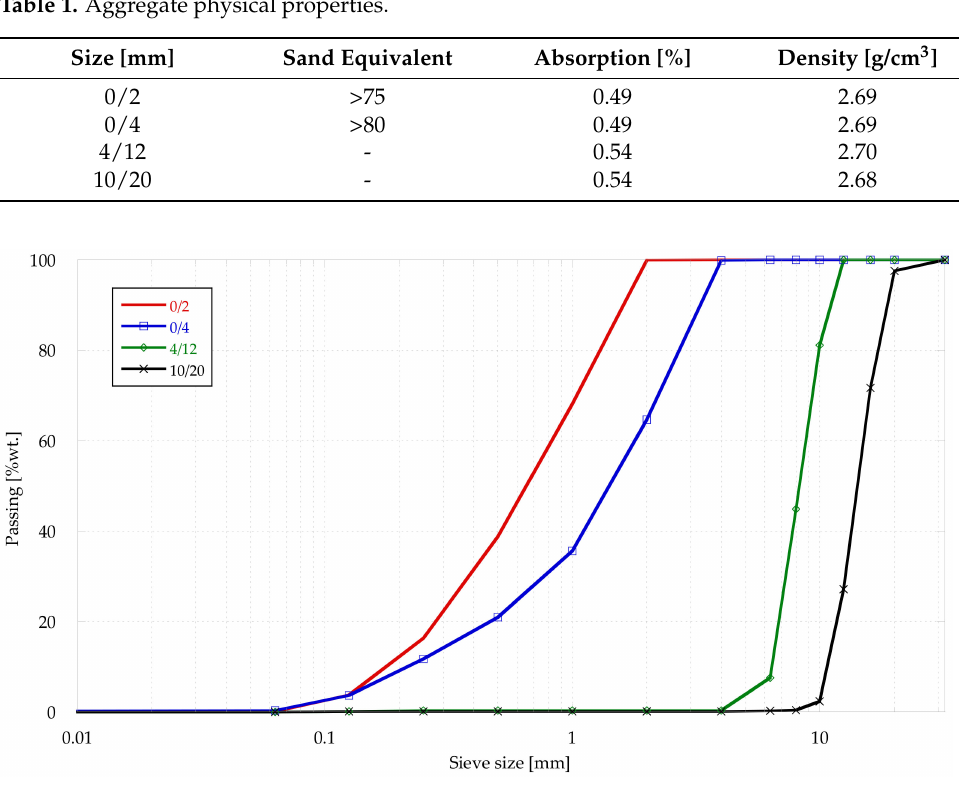
Figure 1. Grading curve. The selected steel fibres were hooked-end type, HE 90/60 made by ArcelorMittal, with a length ( lf ) of 60 mm, a diameter ( df ) of 0.90 mm and an aspect ratio ( λ = lf/df) of 67 and a tensile strength of approximately 1200 N/mm 2 . An example of the fibres used is shown in Figure